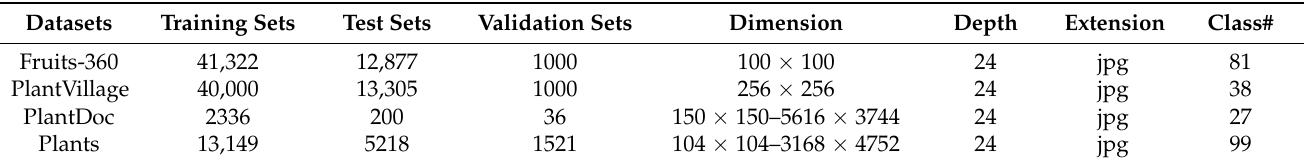
Table 9. Summary of the datasets.